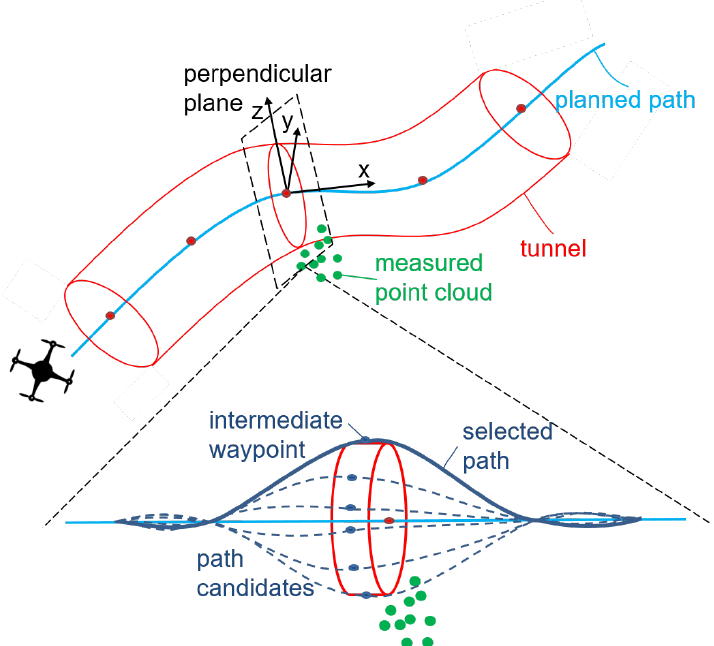
Figure 3. Perpendicular plane and normal vector on tunnel or corridor and a enlarged figure to illustrate how to generate path